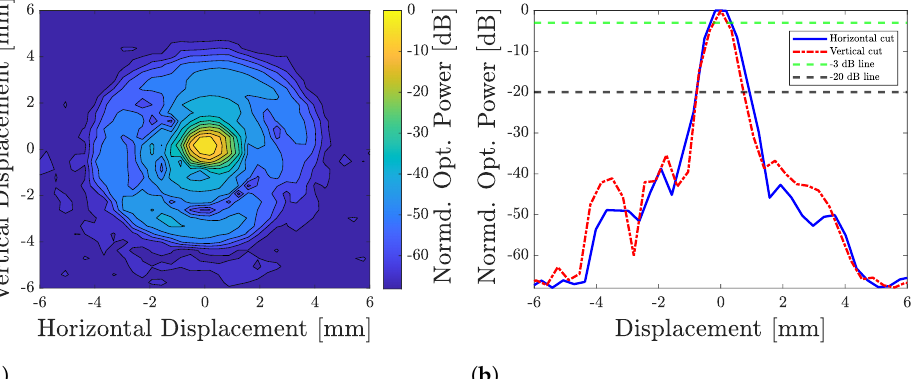
Figure 5. ( a ) SSMF contour map of power received at col1 for the different beam focus. ( b ) SSMF respective power penalty of beam misalignment.